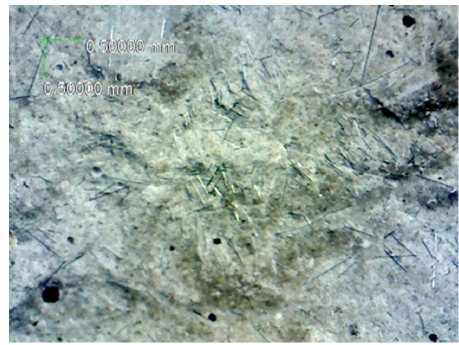
Figure 15. The optical microscopic photo of the specimen unprocessed carbon fibers after impact test.